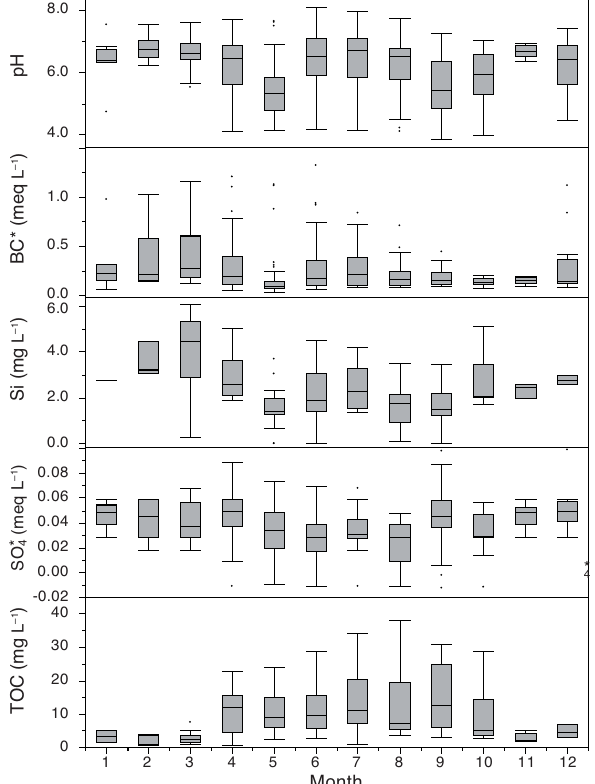
Fig. 5. Seasonal variation in water chemical parameters at unlimed ) and total or- 4 conditions. Boxes represent 25, 50 and 75 percentiles and whiskers represent 10 and 90 percentiles of monthly concentrations measured in all streams for all years.